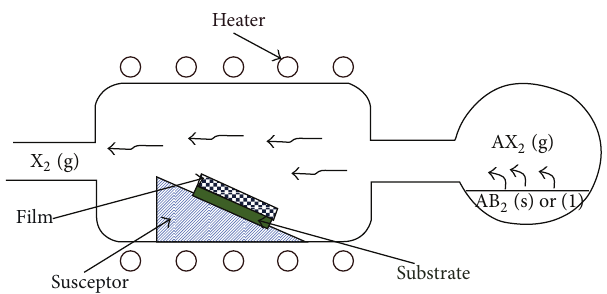
Figure 1: A schematic diagram of the CVD coating